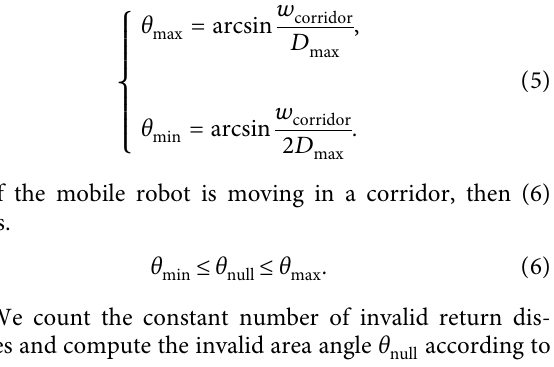
dotted line in the subsequent process. Ideally, the mobile robot moves along the middle red dotted line in Figure 2(a).